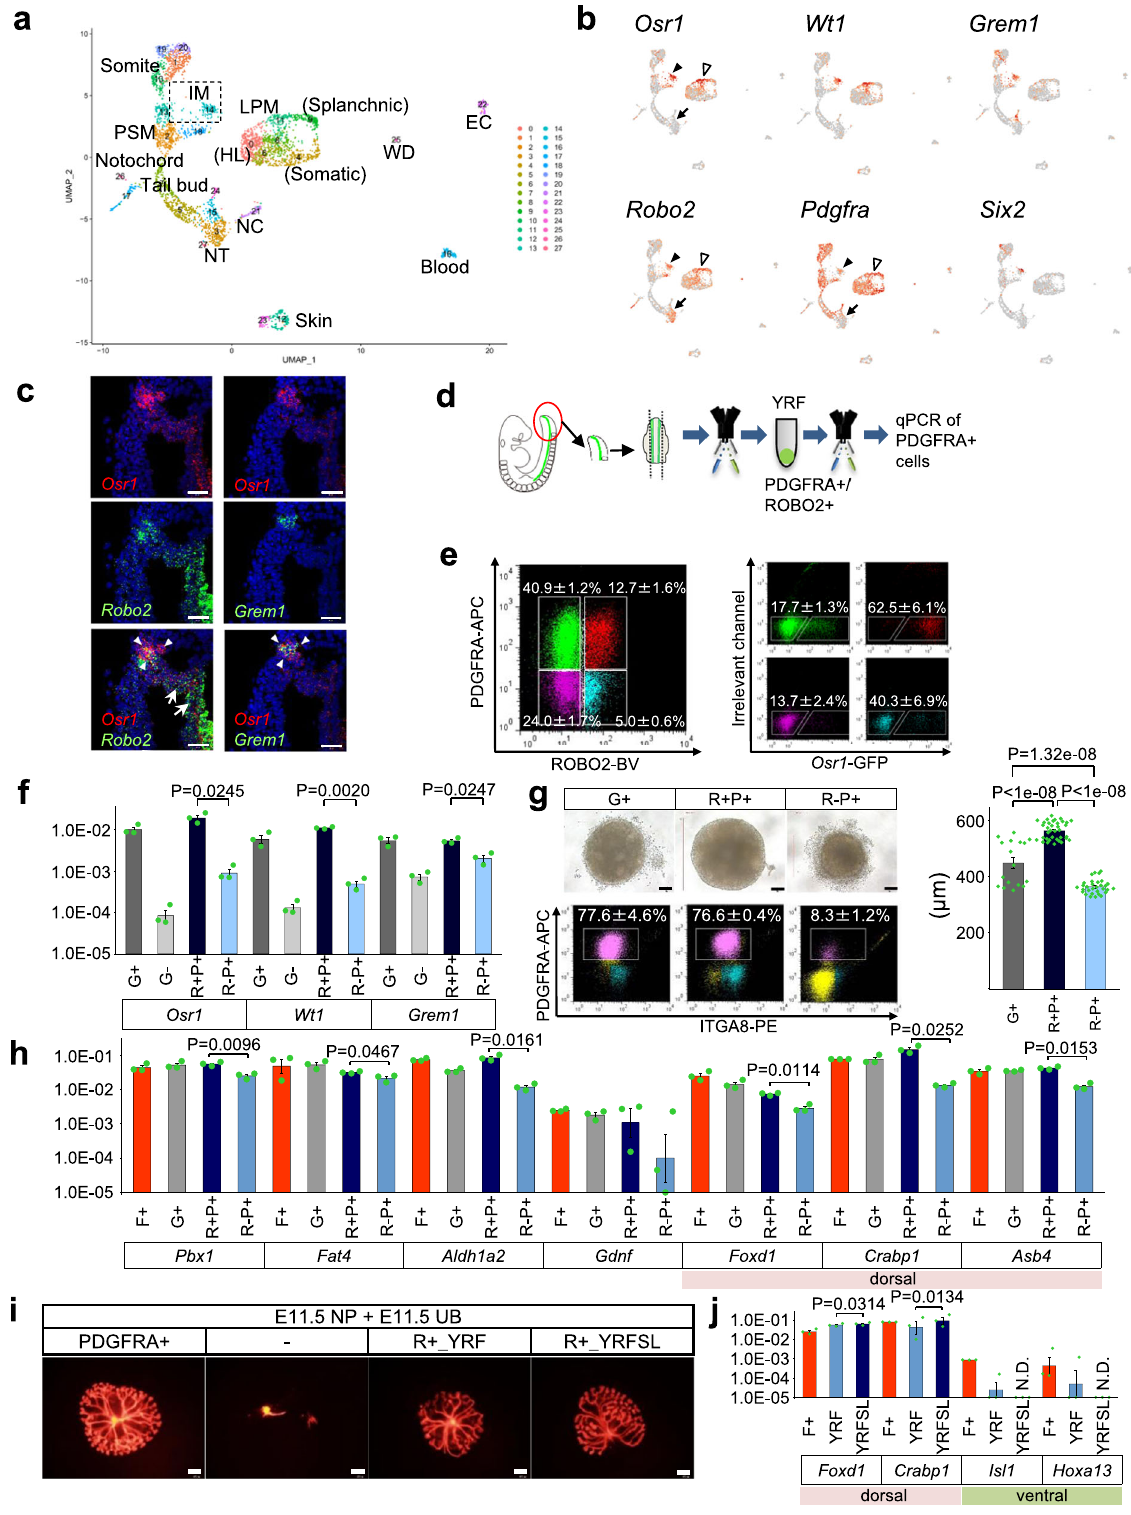
(Supplementary Fig. 2h). Indeed, dorsal SP genes were increased, while ventral SP genes were downregulated (Fig. 2j and Supplementary Fig. 2i). The functional competence of the cultured cells was con fi rmed by aggregation with E11.5 embryonic kidney-derived NPs and an isolated UB, which resulted in extensive UB branching (Fig. 2i and